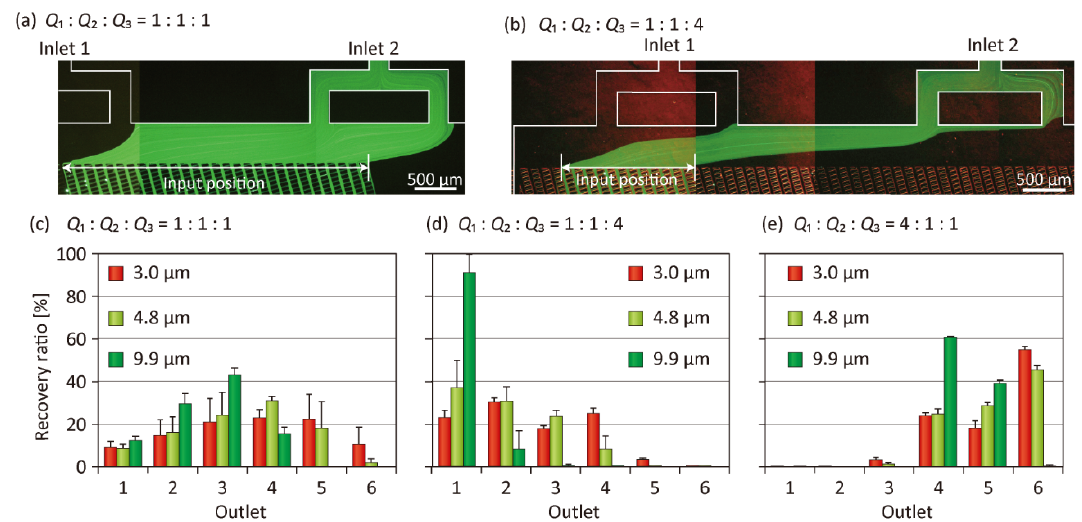
Figure 4. ( a , b ) Fluorescence micrographs exhibiting the behaviors of green fluorescent particles flowing into the lattice region of Microdevice A, when the ratios of the input flow rates were changed as indicated. ( c – e ) Recovery ratios of three types of particles when the ratio of the input flow rates was changed. The total flow rate Q total was constant at 120 µ L / min for these experiments. Each set of data represents the mean ± standard deviation (SD) from three individual experiments.